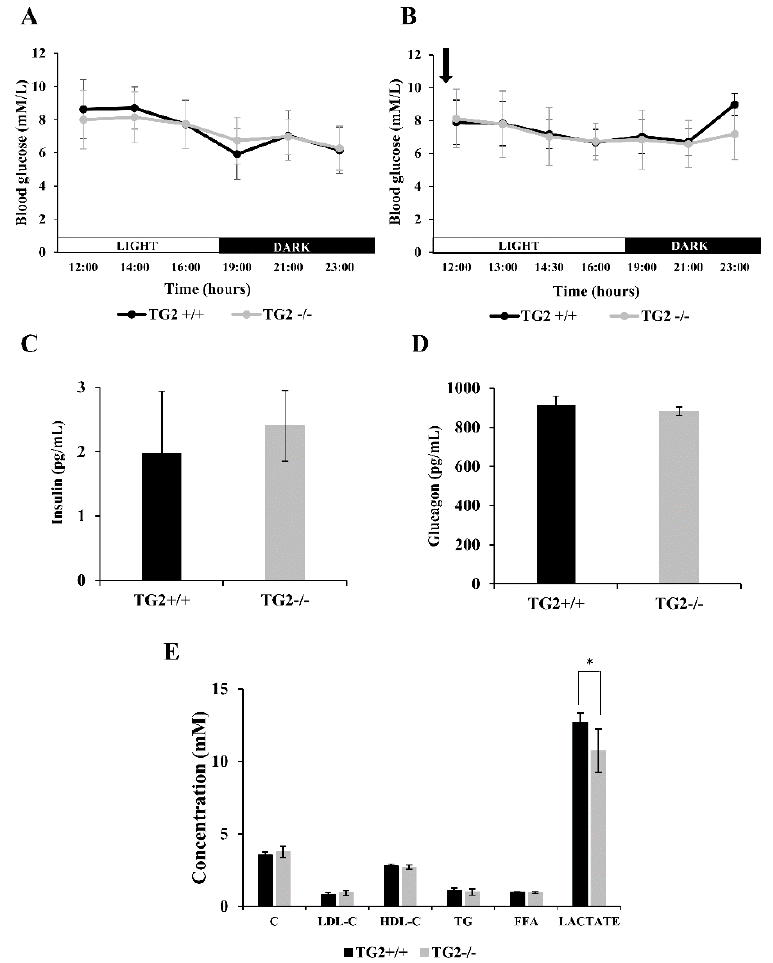
Figure 3. Blood metabolic parameters of TG2 +/+ and TG2 - / - mice after phenylephrine treatment. ( A ) Blood glucose levels of TG2 +/+ and TG2- / - mice on the control day. ( B ) Blood glucose levels of TG2 +/+ and TG2 -/- mice after phenylephrine treatment. Day (□) and night ( ■ ) periods are shown on the “X” axes. Arrowhead indicates the time point of phenylephrine injection. The experiments were carried out according to the scheme presented in Figure 4A. ( C ) Insulin concentration in serum samples of TG2 +/+ and TG2 - / - mice 13 h after phenylephrine treatment. ( D ) Glucagon concentration in serum samples of TG2 +/+ and TG2 - / - mice 13 h after phenylephrine treatment. ( E ) Serum lipid and lactate concentration values of mice 13 h after phenylephrine treatment. C: cholesterol, LDL-C: low-density lipoprotein cholesterol, HDL-C: high-density lipoprotein cholesterol, TG: triacylglycerol, FFA: free fatty acid. Columns or measurement points represent the mean values ± SD. Statistical analyses were performed using Student’s t -test ( n = 5, * p <